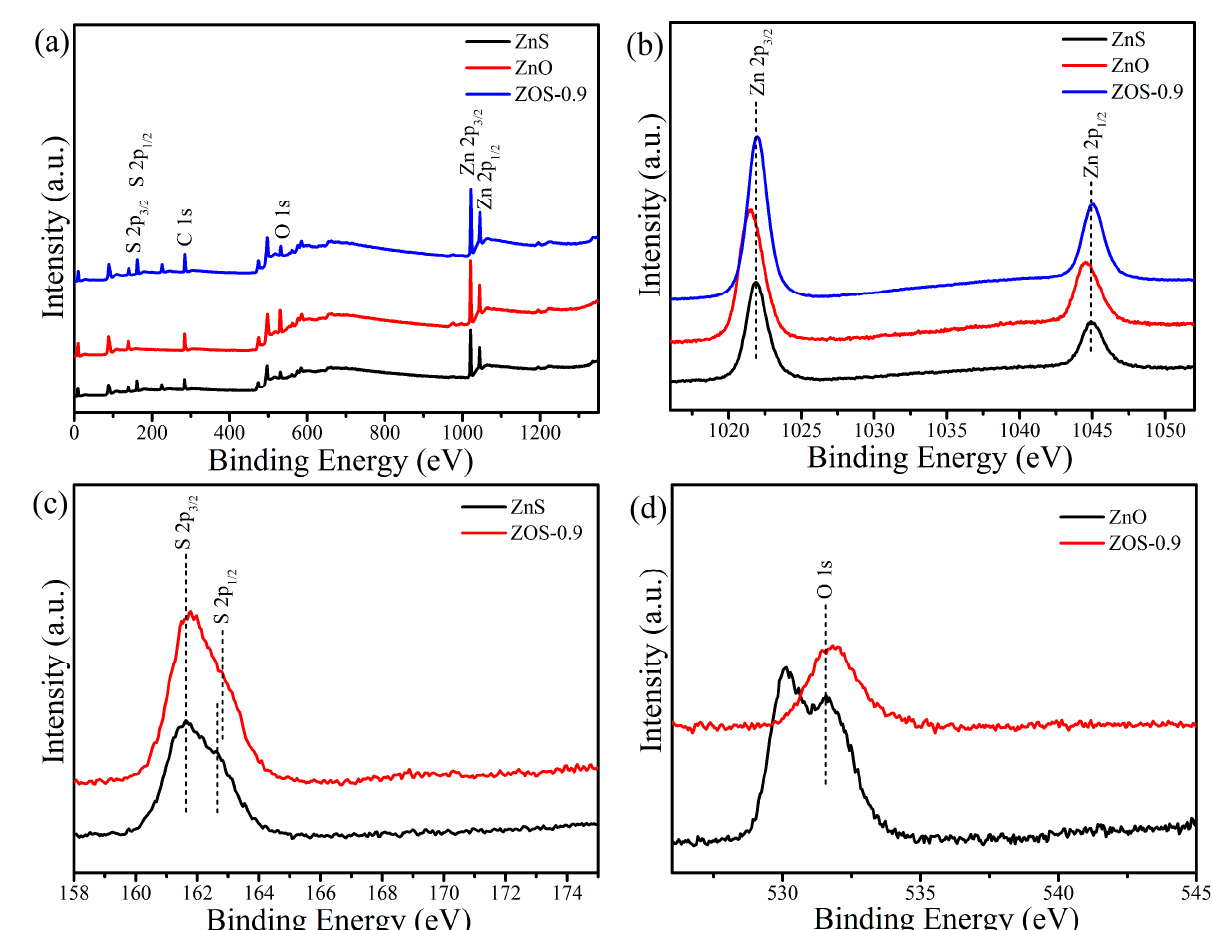
Figure 4. XPS spectra of ZnO, ZnS, and ZOS-0.9 ( a ) survey, ( b ) Zn 2p, ( c ) S 2p, ( d ) O 1s. To study the optical properties of the samples, the UV-Vis diffuse reflectance properties of ZnO, ZnS and ZnO/ZnS photocatalysts were considered. In Figure 5a, the absorption edges of both ZnO and ZnS were around 380 nm. Compared with them, the absorption edge of ZnO/ZnS photocatalyst first shifted blue and then red with the increase in ZnS content. According to the formula α h ν = A(h ν − E g ) n/2 , the forbidden band width of the semiconductor can be calculated. Since both ZnO and ZnS were direct bandgap semiconductors, n was taken as 1, and both sides were squared. Figure 5b was obtained by plotting ( α h ν ) 2 against the energy h ν . A tangent was drawn, and the intersection of the tangent and the abscissa was the forbidden band width of the semiconductor [42]. It can be obtained that the forbidden band widths of ZnO, ZnS, ZOS-0.1, ZOS-0.3, ZOS-0.5, ZOS-0.7, ZOS-0.9 and ZOS-0.95 were 3.30 eV, 3.38 eV, 3.32 eV, 3.60 eV, 3.62 eV, 3.65 eV, 3.56 eV and 3.53 eV, respectively. Among them, ZOS-0.9 had a larger absorption edge and a smaller band gap. Therefore, it was more likely to be excited by light to generate carriers, and photocatalytic reactions were more likely to occur on the surface